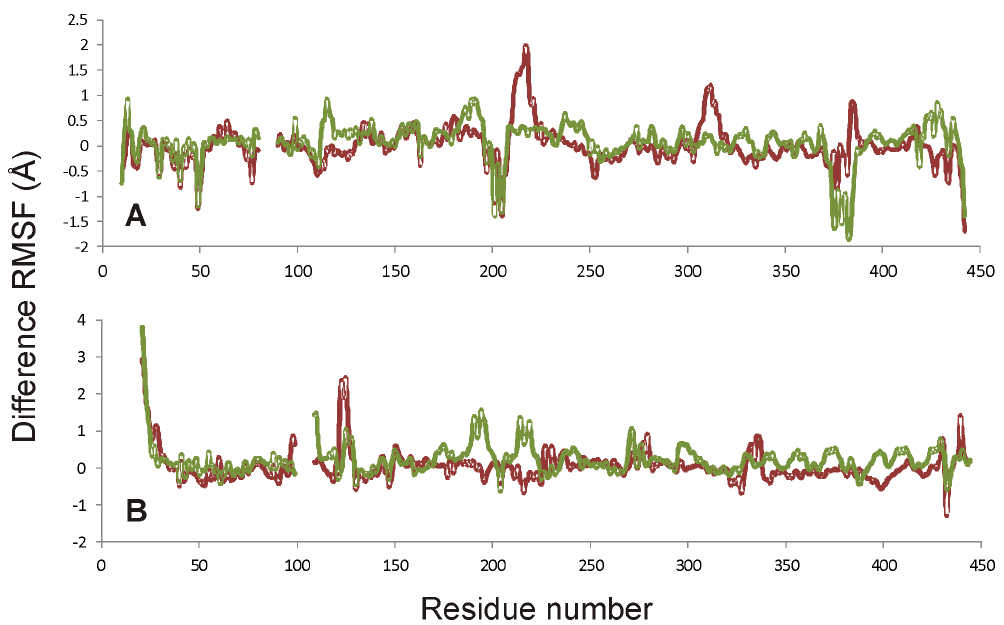
Figure 4. Influence of mutations on difference RMSF values from molecular dynamics simulations. The difference RMSF values were calculated by subtracting the RMSF for the wild type protein from that of the mutant protein. Both panels represent equally spaced sampling of 10 ns simulations. Blank areas at the beginning and near residue 100 represent the sections of the structure that were not present in the original X-ray structure and were not used in calculating the RMSF values. A. Small subunit results; red is Stu S Q75A and green is Stu S W116A . B. Large subunit results; red is Stu L Q86A and green is Stu L W128A .